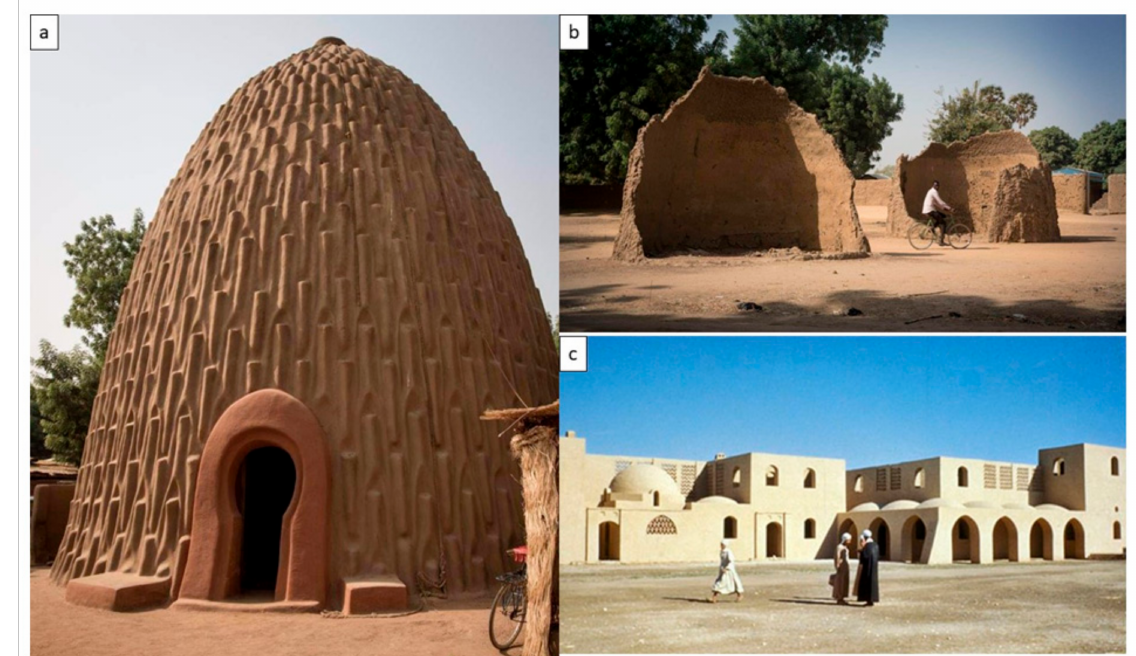
Figure 2. Vernacular clay architecture in Africa with simple building technologies: ( a ) shows Mousgoum houses built with clay by manual methods, while ( b ) exhibits the ruins of some of these Mousgoum houses due to cracking or poor rain resistance due to the hydrophilic nature of clay materials, and ( c ) exhibits earthen architecture by Hassan Fathy in New Gourna village in South Egypt, exploiting the passive cooling nature of clay materials through employing it in the design and construction of passive cooling Islamic architectural elements [29] (Photos: Institute of Nomadic Architecture.